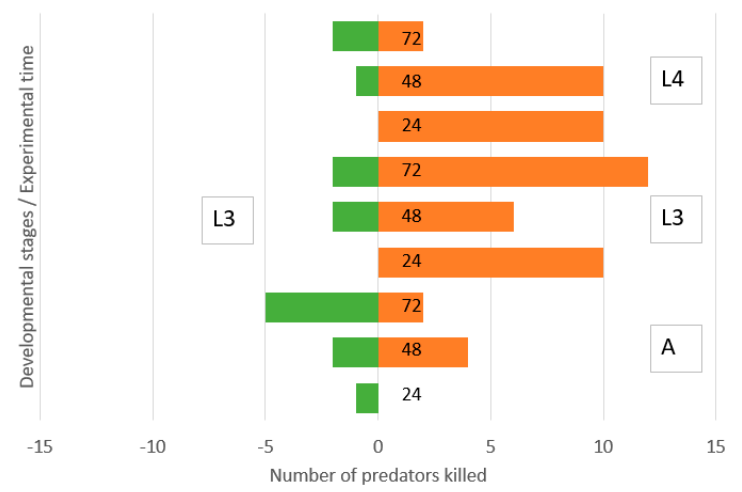
Figure 4. Direction of intraguild predation between Chrysoperla carnea , third instar larvae, and Hippodamia variegata adults (A), third instar larvae (L3) and fourth instar larvae (L4) in a simple arena. Numbers of predators killed of initial N = 40 during 0–24, 24–48 and 48–72